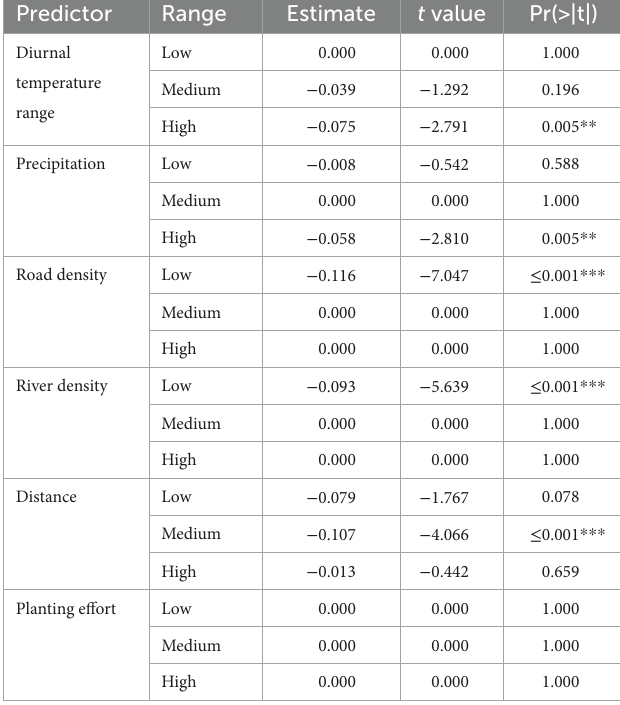
TABLE 3 Results of multi-site generalised dissimilarity modelling of widespread species ( ζ 5 ). Predictor Range